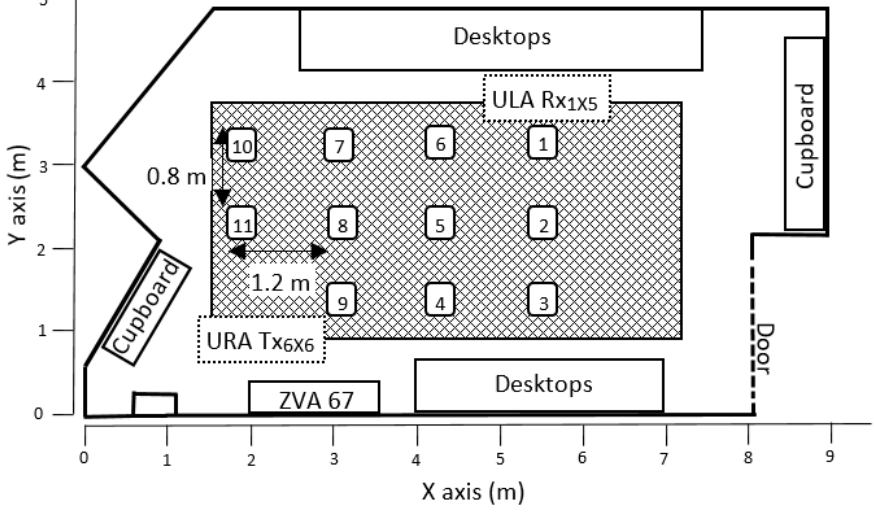
Figure 1. Location of Tx and Rx in the laboratory.